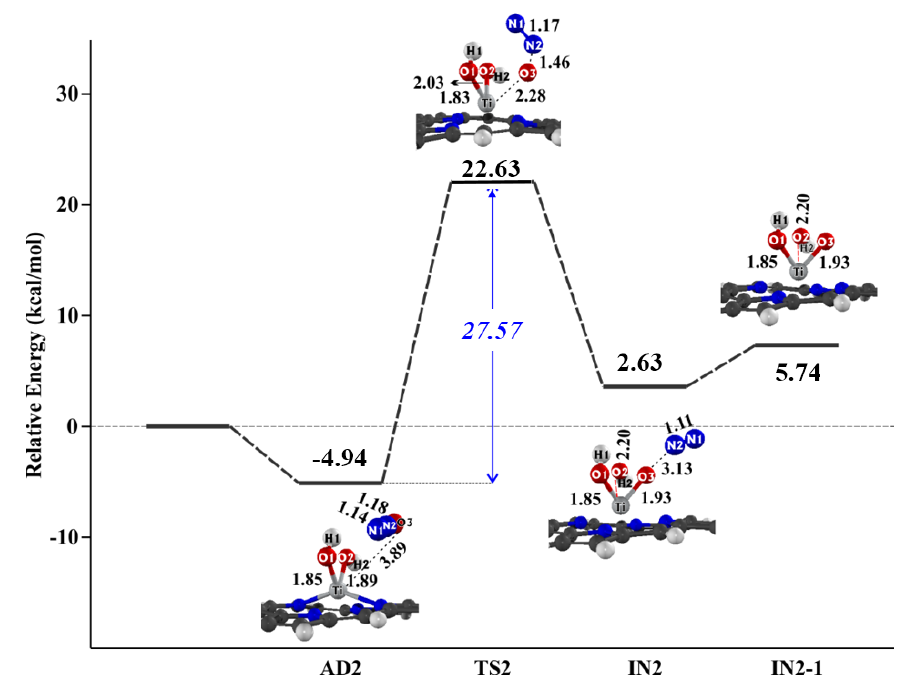
Figure 3. The first N 2 O decomposition over the hydroxyl-oxotitanium porphyrin (Ti(OH) 2